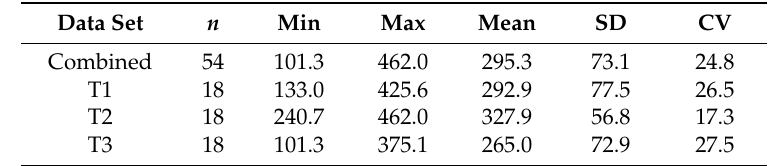
Table 1. Descriptive statistics of rice grain yield (g m − 2 ). Data